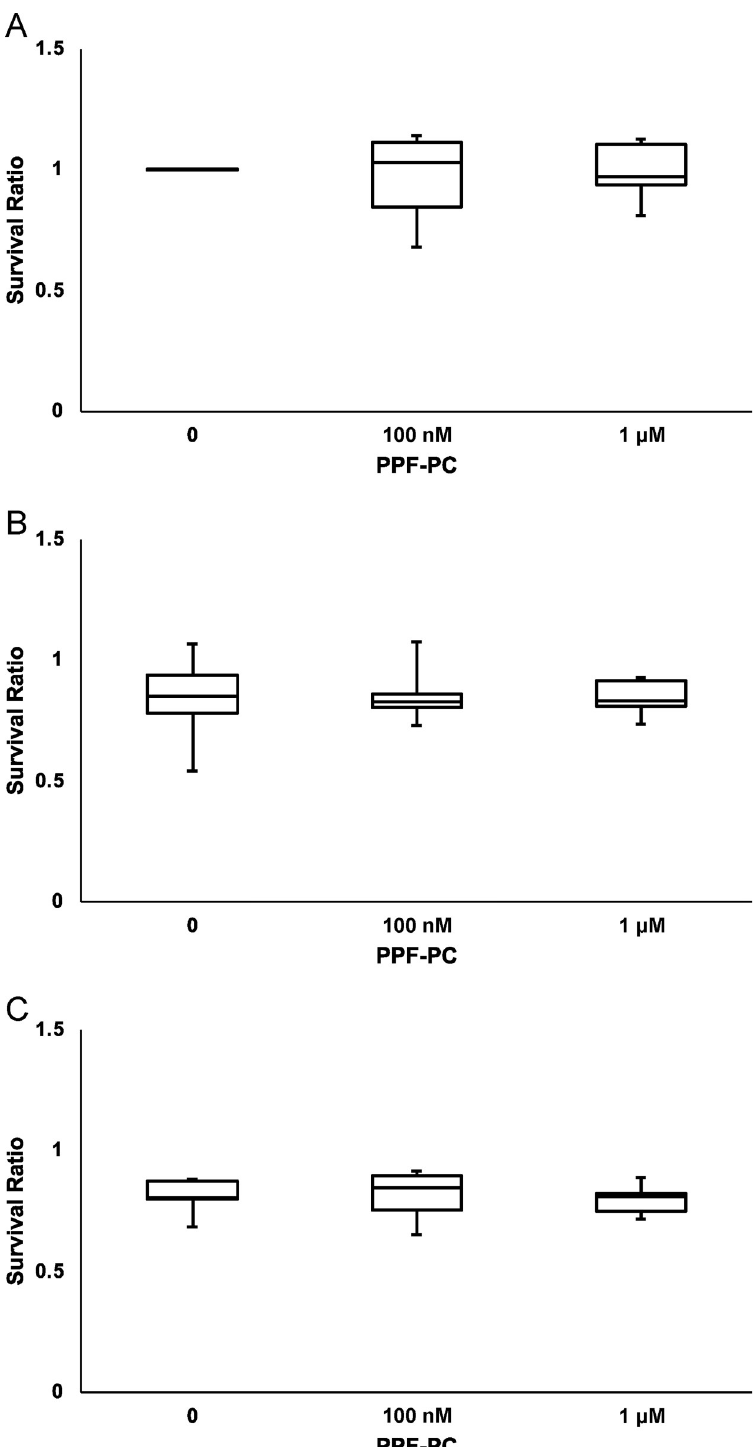
Fig 7. Survival ratio (SR) of primary cultured cortical neurons exposed to vehicle (DMSO in PBS (A); PPF at (B) 10 or (C) 100 μ M) for 24 h during DIV 3 and 4. Although exposure to PPF elicited a significant neuronal death, the decrease in SRs on DIV 3 and 4 were irrelevant to PPF-PC on DIV 2. The differences between the means were calculated using ANOVA, followed by the Tukey–Kramer honestly significant difference test as a post-hoc test.